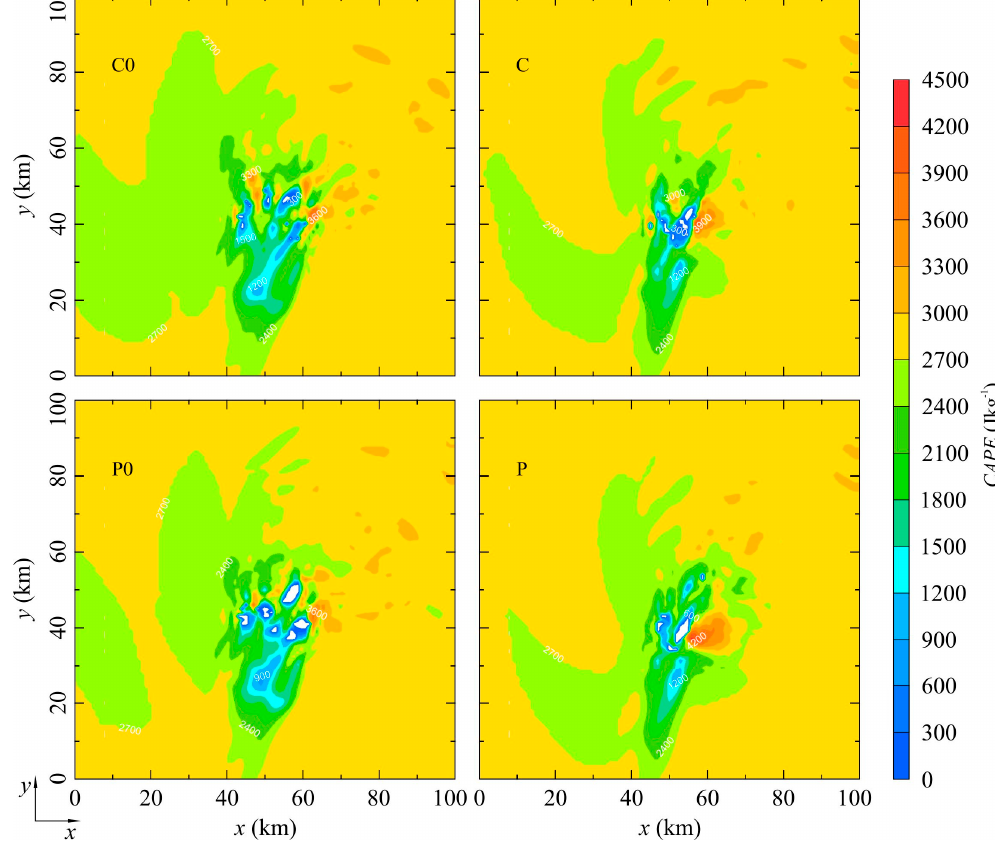
Figure 15. Horizontal distribution of convective available potential energy ( CAPE ) at t = 120 min for the non-drizzle and drizzle cases. Isolines are drawn in intervals of 300 J kg − 1 ; the base isoline is 0 J kg − 1 . The values of CAPE are depicted using a scale on the right-hand side of the figure. A non-shaded areas represent the value of 0 J kg − 1 .